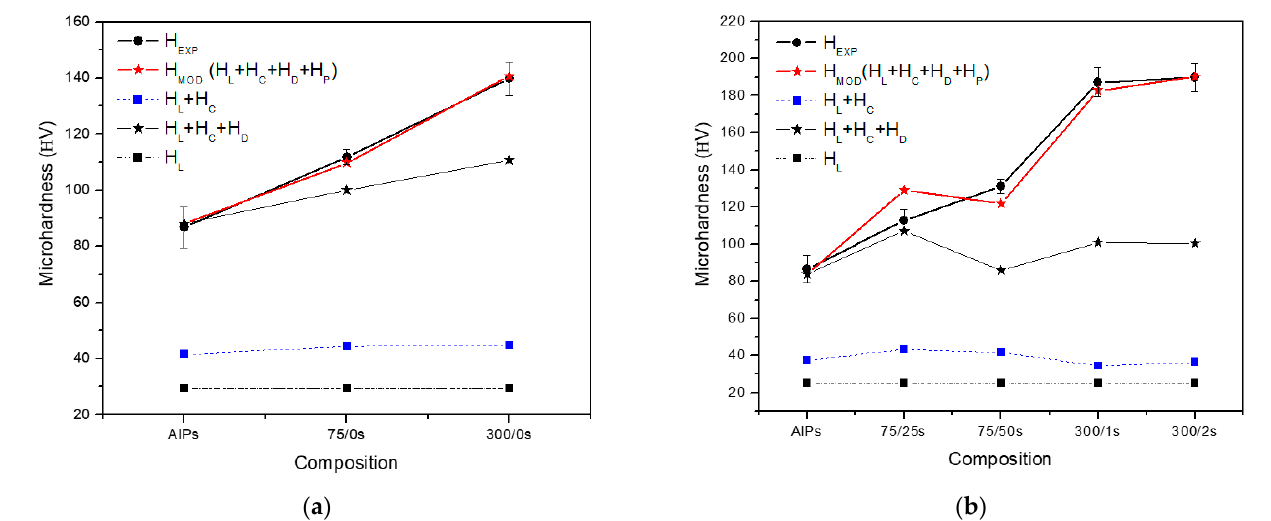
Figure 9. Experimental and calculated microhardness as a function of composition HL, dislocation density (HD), the crystallite size (HC) and particle dispersion and HP contribution microhardness terms for ( a ) Al–C composites and ( b ) Al–C–Cu composites.